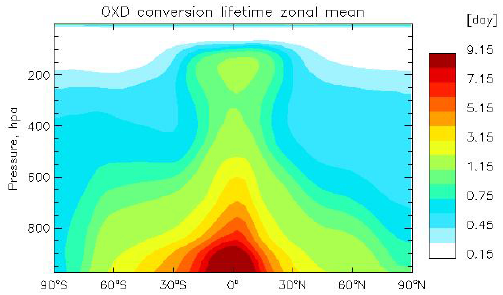
Fig. 2b. Zonal mean plot for hydrophobic to hydrophilic conversion lifetime for carbonaceous aerosol by oxidation aging scheme.